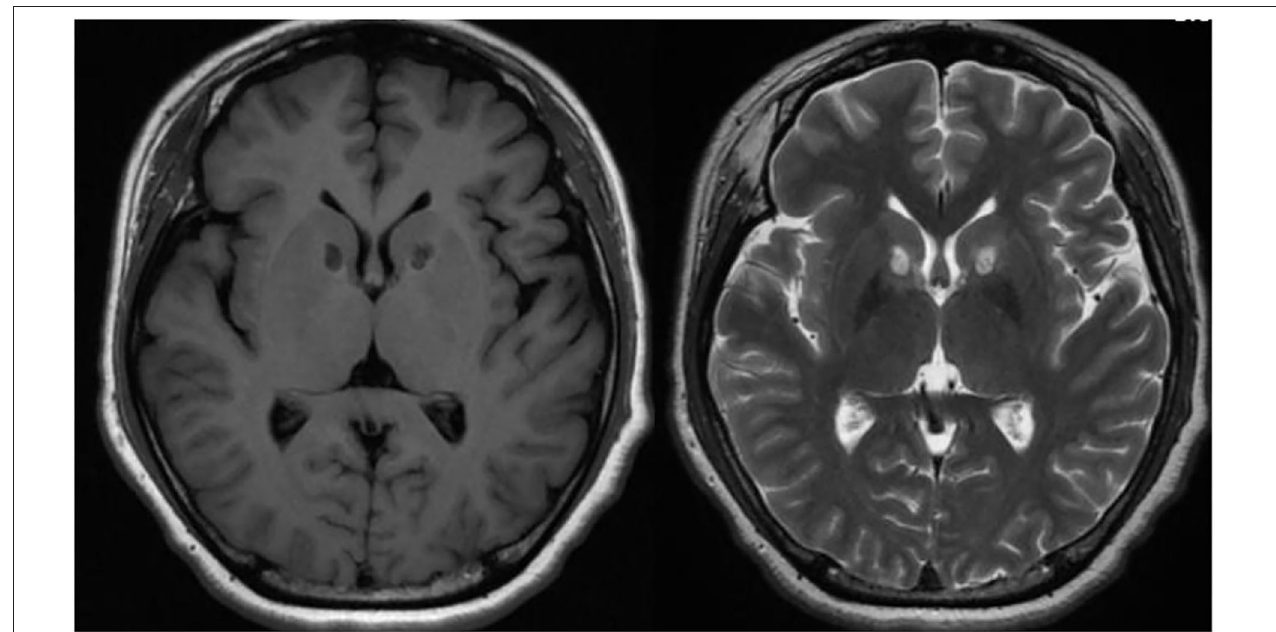
FIGURE 1 | One-week post-operative MR image of a patient with MRgFUS